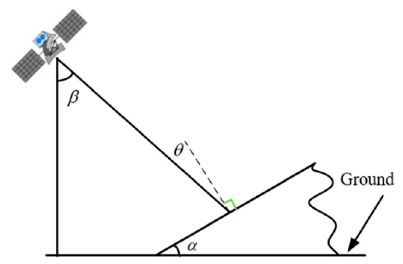
Figure 7. Local incident angle model.